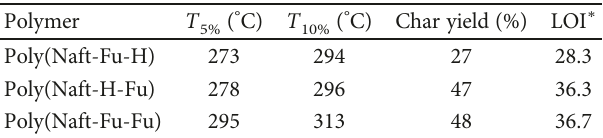
Figure 12: Thermograms of poly(naphthoxazines). (a) TGA, (b) DTGA. Table 3: Summary of the values of TGA thermograms of the poly(naphthoxazines).